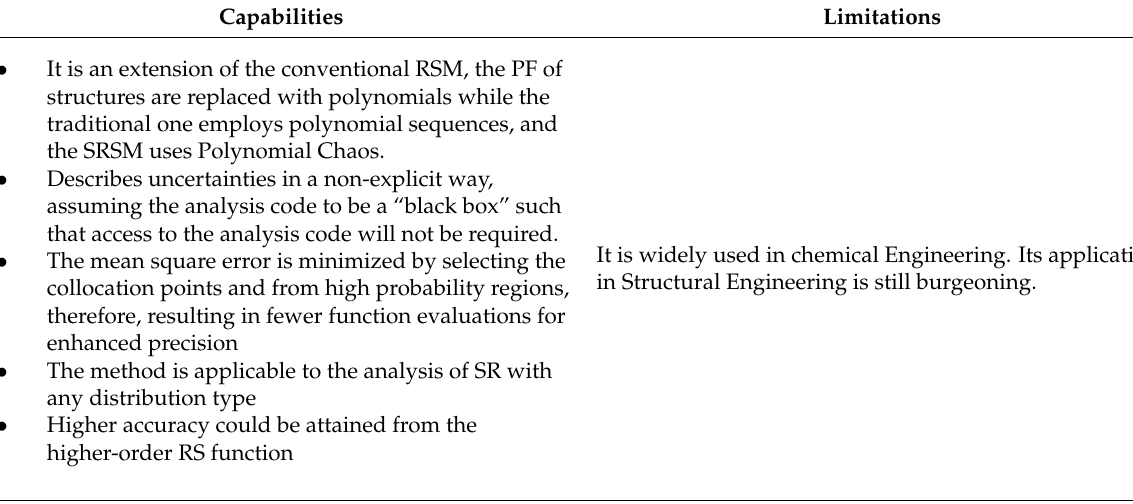
Table 4. Capabilities and limitations of the other common structural reliability